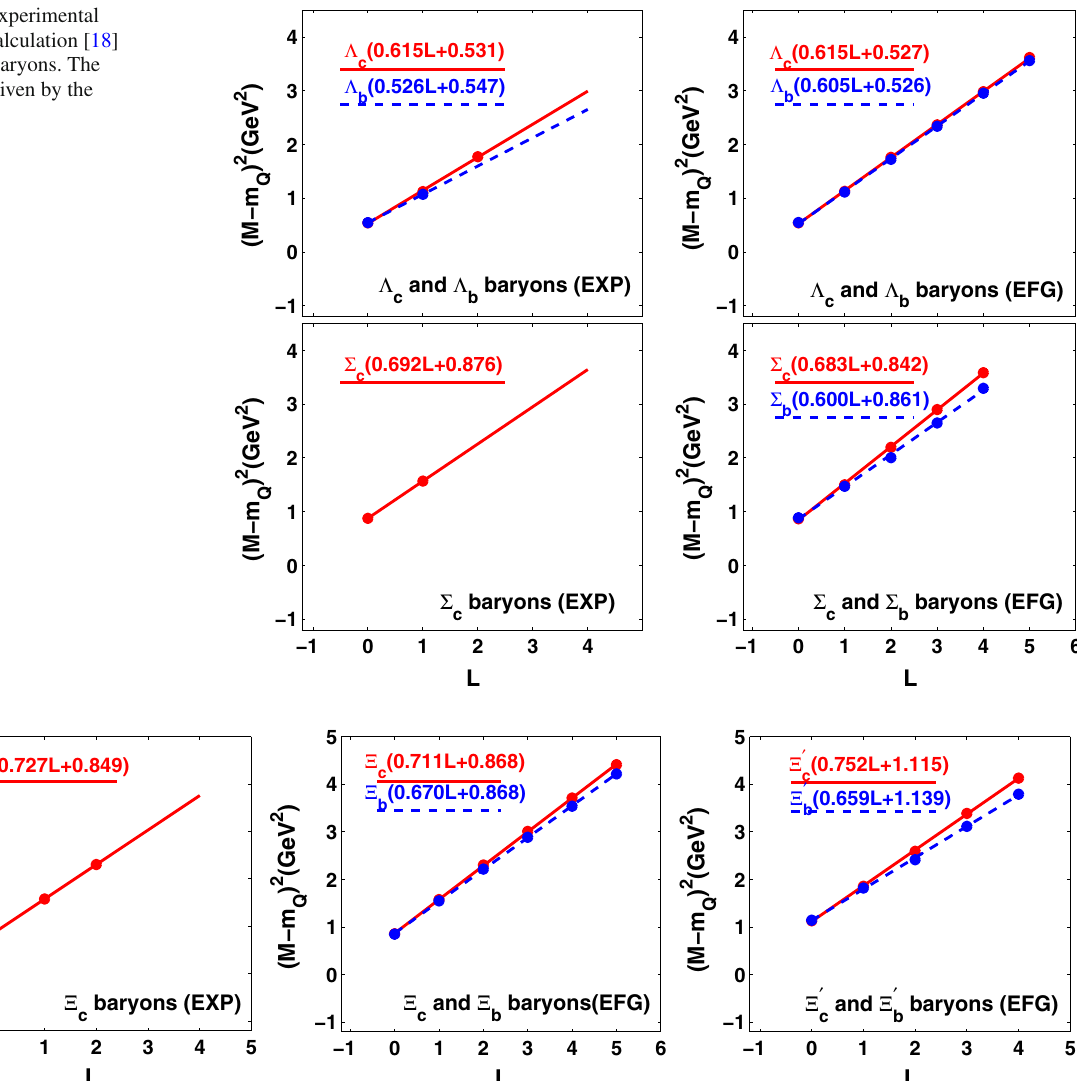
Fig. 6 Plots of experimental data for (cid:7) c baryons and model calculation results [18] of (cid:7) Q and (cid:7) (cid:3)